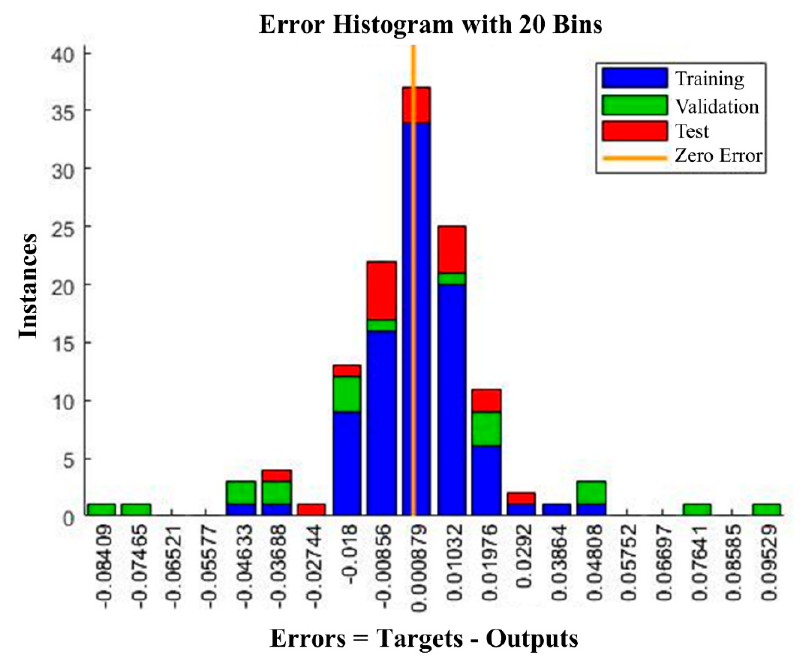
Figure 7. RMS error histogram of the ANN model predictions.